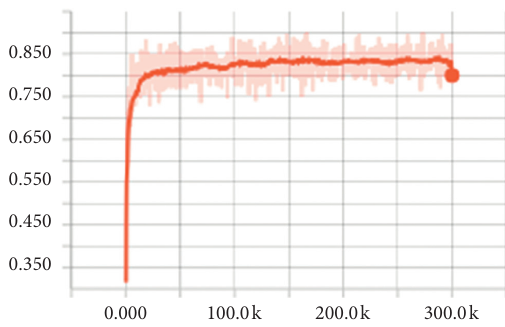
Figure 3: Changes in the accuracy rate of the Dizhu model.